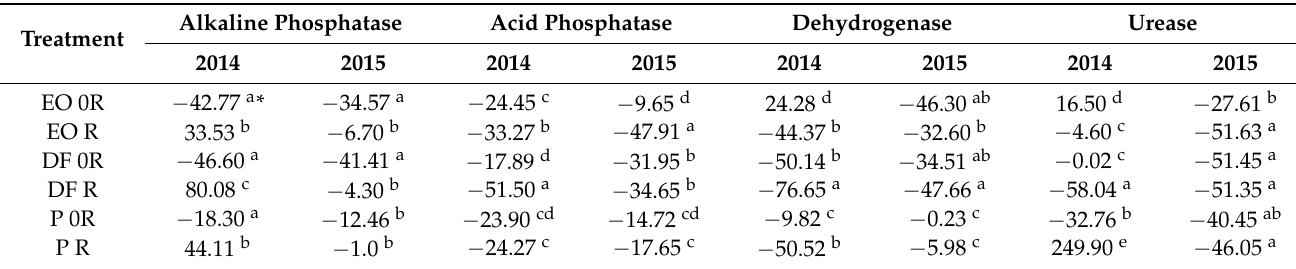
Table 1. Values of the enzyme activity change ratio (ACR) indicator after four (2014) and five (2015) years from soil contamination and the use of